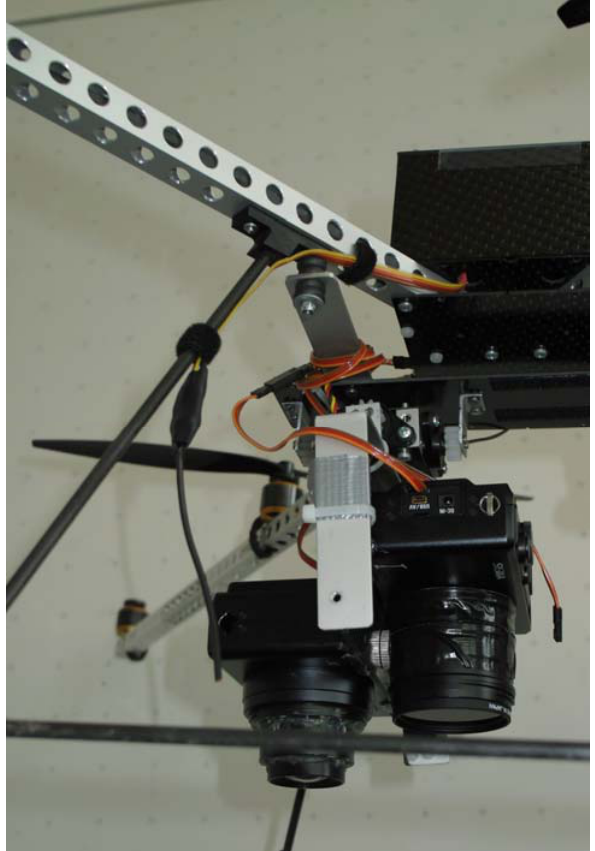
Figure 5. Sensor head with RGB and IR camera